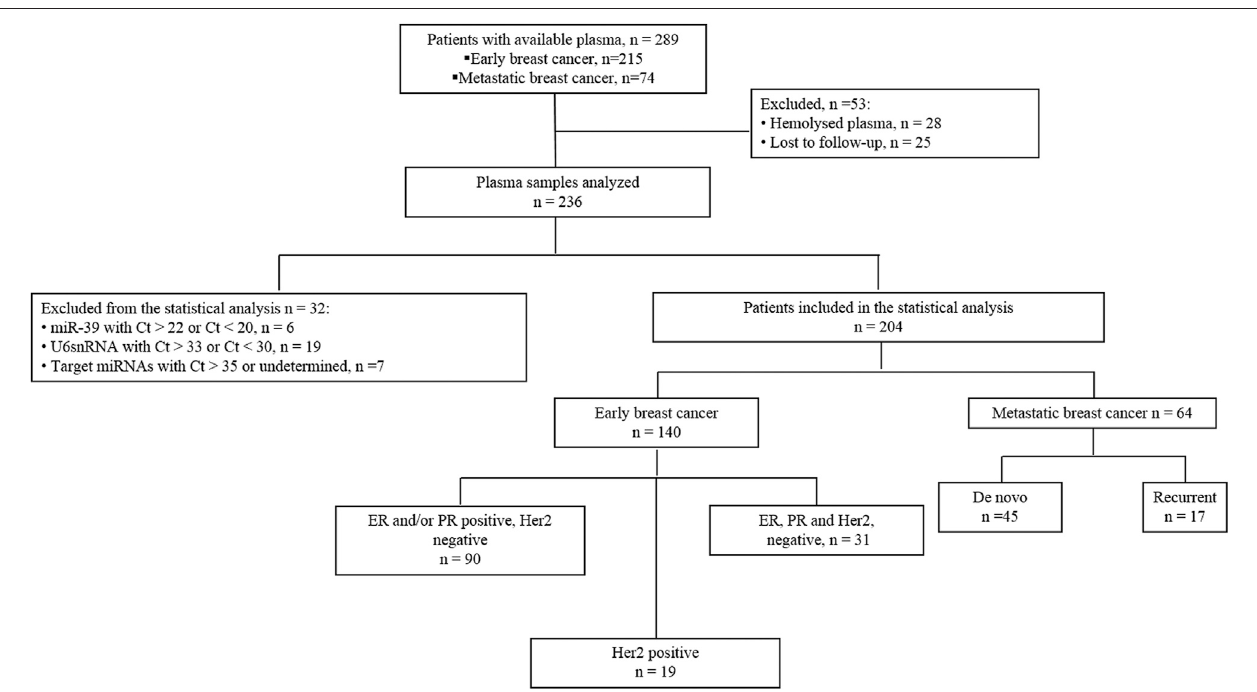
FIGURE 1 | Flow chart of the study. Ct, cycle